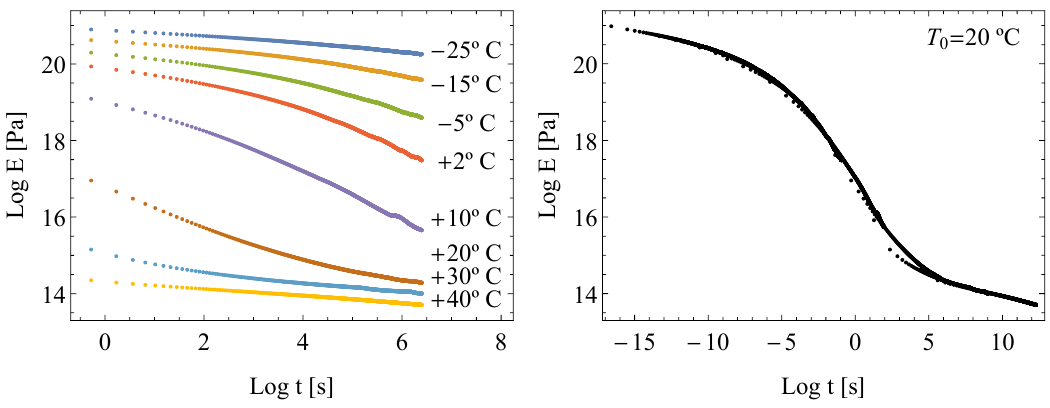
Figure 4. Experimental relaxation curves at different temperatures for the Polyvinil–Butyral (PVB) ( left ), and experimental master curve for 20 o C ( right